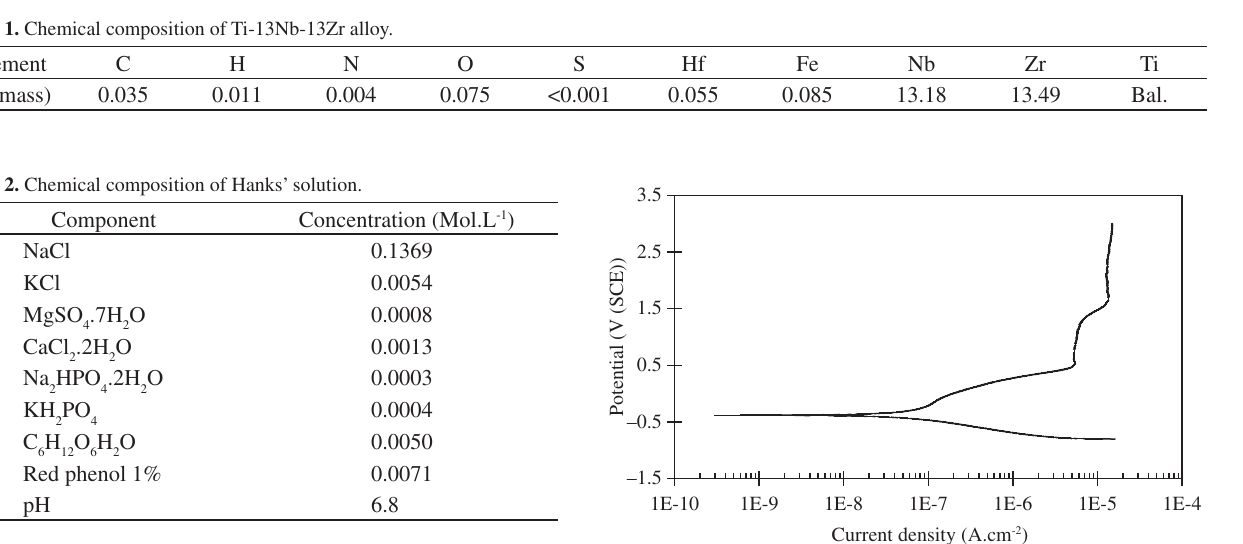
Figure 1. Potentiodynamic polarisation curve for Ti-13Nb-13Zr alloy after 72 hours of immersion in Hanks’ naturally aerated solution at pH 6.8 and 37 °C.